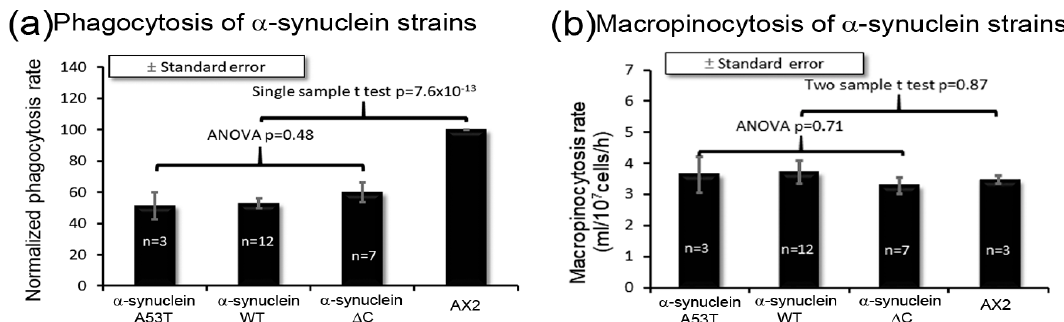
Figure 6. α -Synuclein affects phagocytosis but not macropinocytosis. ( a ) Dictyostelium amoebae were fed E. coli expressing Ds-Red fluorescent protein and duplicate fluorescent measurements were taken immediately after the addition of bacteria and after 30 min of incubation at 21 °C on a shaker. The uptake rates were normalized to the uptake rate for AX2. The indicated number of strains ( n ) expressing each mutant α -synuclein form all showed a similar, significantly reduced rate of phagocytosis compared to the parental strain AX2, but there were no statistical differences among them (ANOVA with pairwise comparisons using the Least Squares Difference test). In a single sample t-test, the normalized phagocytosis rates for strains expressing α -synuclein forms were significantly lower than 100% (the parental strain, AX2). Each strain was assayed in at least three independent experiments. ( b ) Dictyostelium amoebae were fed HL-5 medium containing FITC-dextran and duplicate fluorescent measurements were taken immediately after the addition of FITC-dextran and after 70 min of incubation at 21 °C on a shaker. Compared to the parental strain AX2, macropinocytosis was unaffected in all the α -synuclein-expressing strains. Cell lines were measured in at least three independent experiments and error bars represent standard errors of the mean. The difference from AX2 was not significant at indicated p value (two sample t -test) and the differences among all α -synuclein strains were not significant (ANOVA and pairwise comparisons using the Least Squares Difference test).